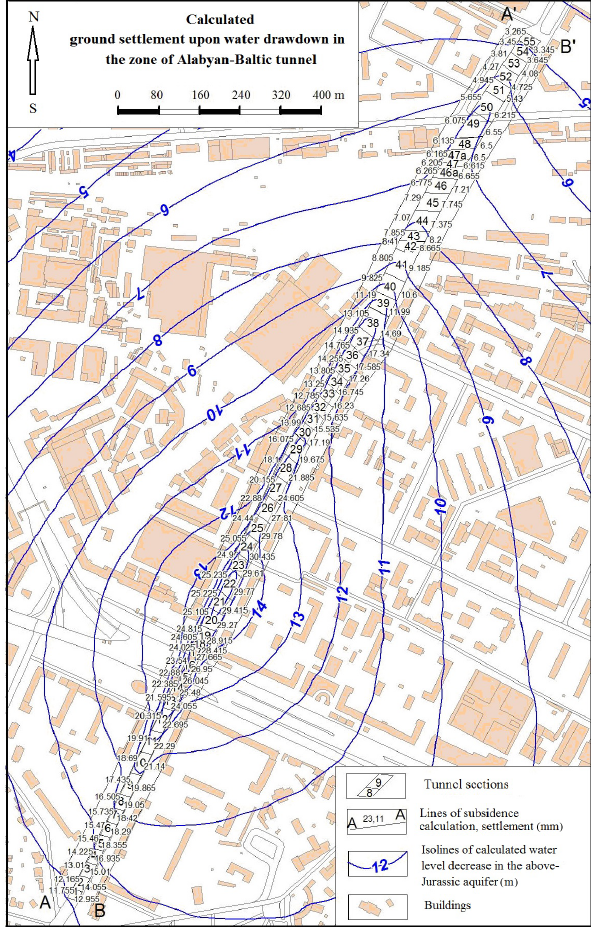
Figure 3. Map of isolines of lowering groundwater level and sub- sidence distribution along the tunnel